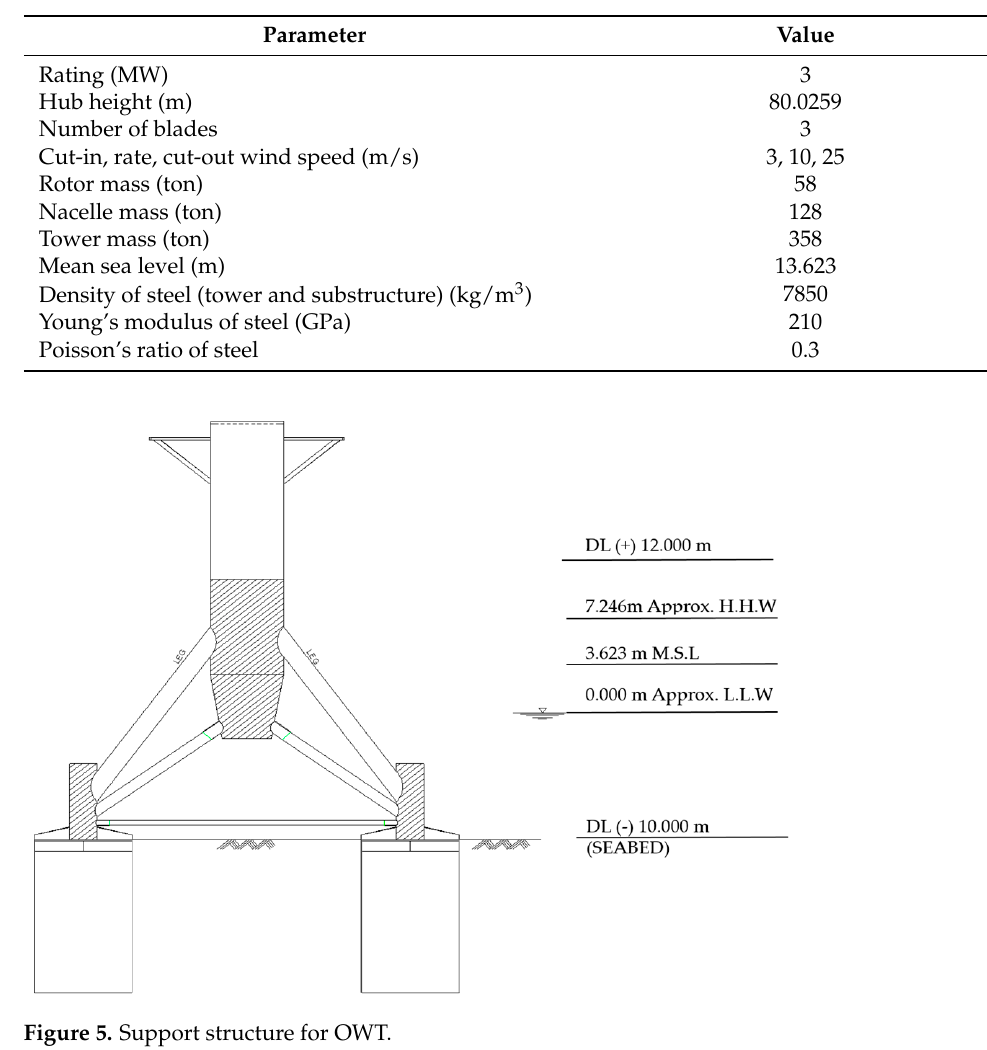
Table 2. 3 MW-capacity wind turbine main parameters.